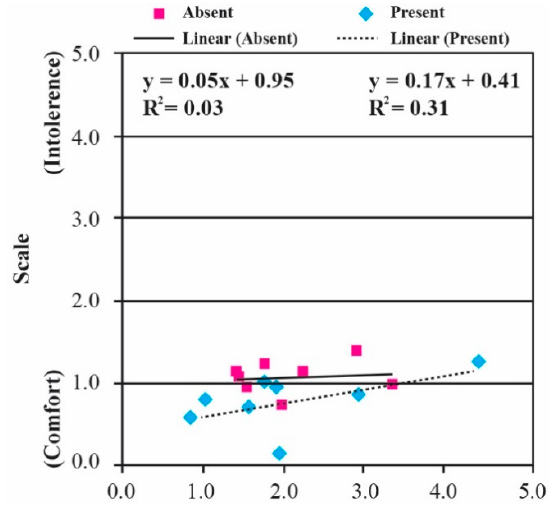
Figure 9. Indoor air quality acceptance with or without plant placement.